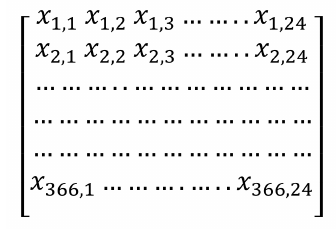
Figure 7. Model of 366 × 24 order matrix.